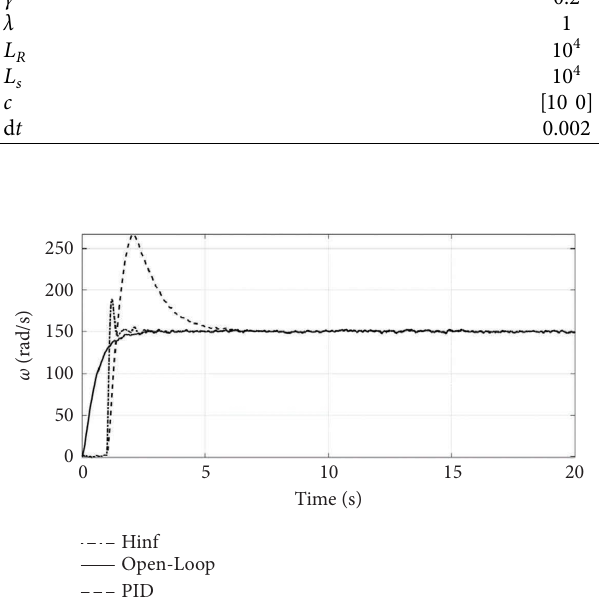
Figure 10: Te angular velocity of the second-order system for τ � 1s and stochastic disturbance.